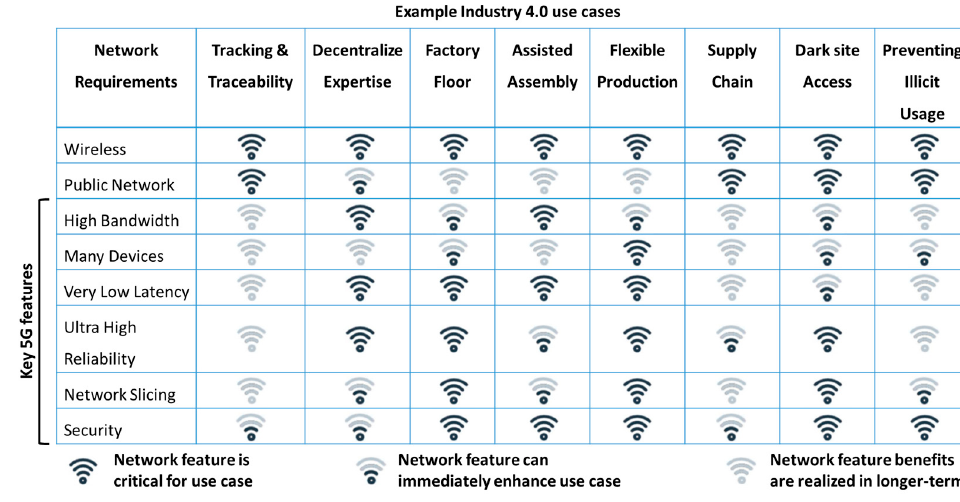
Figure 10. Existing and future use cases aligned to 5G technical capabilities [52].